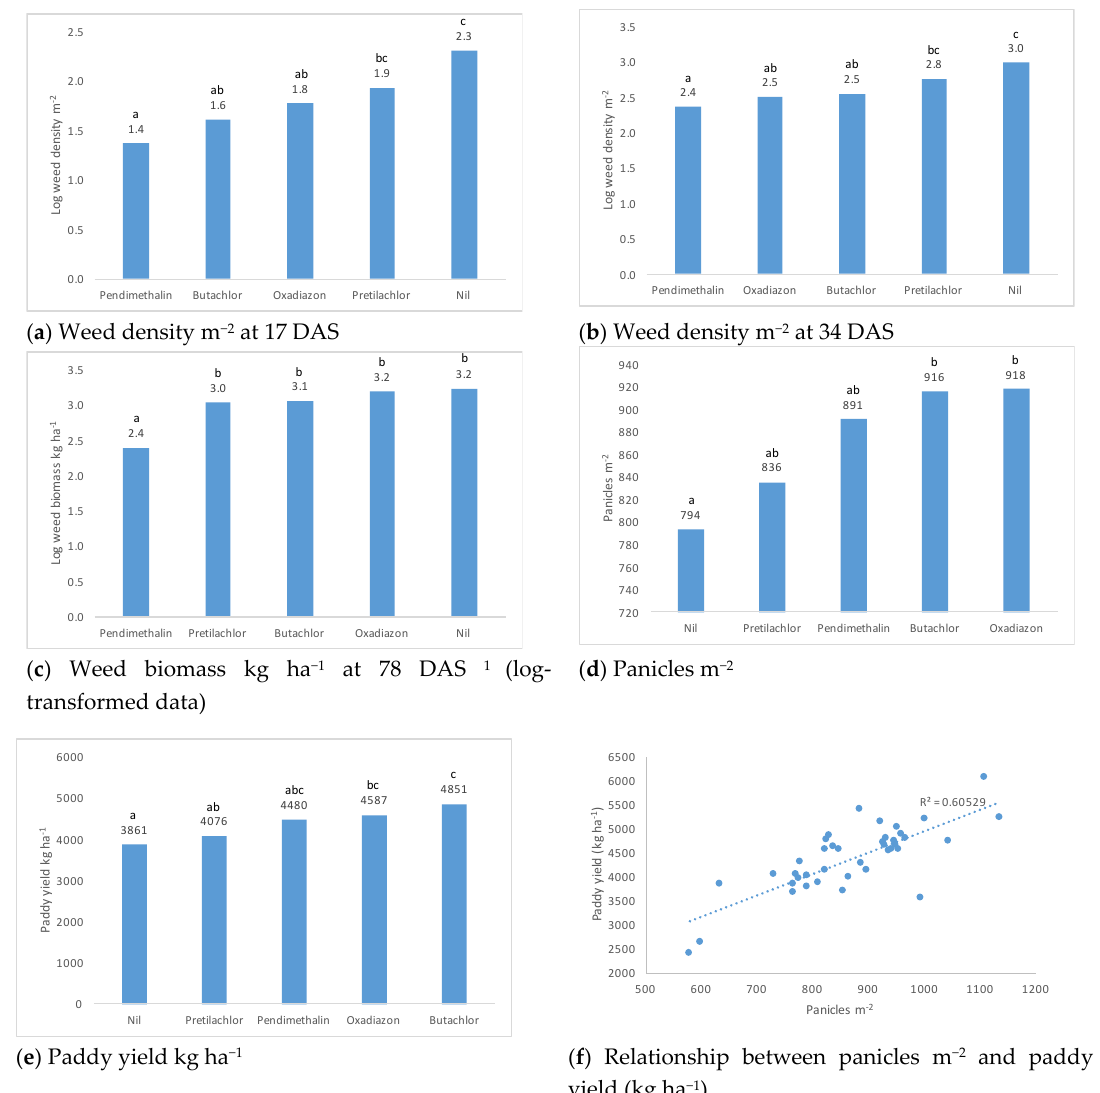
Figure 6. Effect of pre ‐ emergence herbicides on yield components in 2019 (means that share the same Figure 6. E ff ect of pre-emergence herbicides on yield components in 2019 (means that share the same letter are not significantly different). letter are not significantly di ff erent).